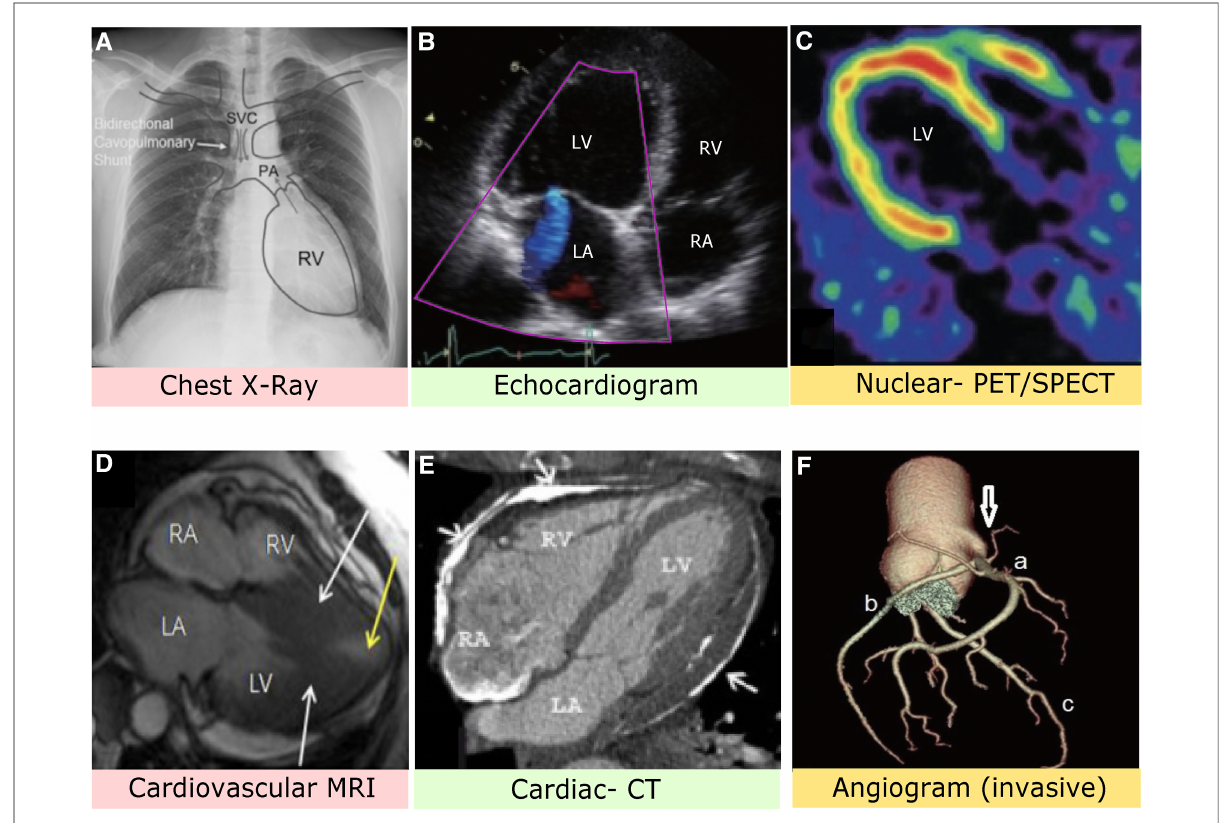
FIGURE 2 ( A ) Chest x-ray image with anatomical identi fi cation of relevant heart structures. Grey arrows represent blood fl ow. SVC, superior vena cava; PA, pulmonary artery; RV, right ventricle (8). ( B ) Stress-induced cardiomyopathy via echocardiogram depicting apical four heart chamber view. LV, left ventricle; LA, left atrium; RV, right ventricle; RA, right atrium (9). ( C ) PET imaging with contrast allows assessment of blood fl ow and cardiac sympathetic innervation of the LV (10). ( D ) MRI with nuclear enhancement revealed an obstructed LV (white arrows) and decreased blood fl ow. The patient had complaints of angina and dyspnea (11). ( E ) Axial CT image identi fi es extensive plaque of pericardial layers (arrows) and deformity suggestive of pericardial constriction (12). ( F ) Computed CT angiogram indicates the right coronary sinus (arrow) with a mitral valve anomaly. A: Right coronary artery, B: Left circum fl ex artery, C: Left anterior descending artery